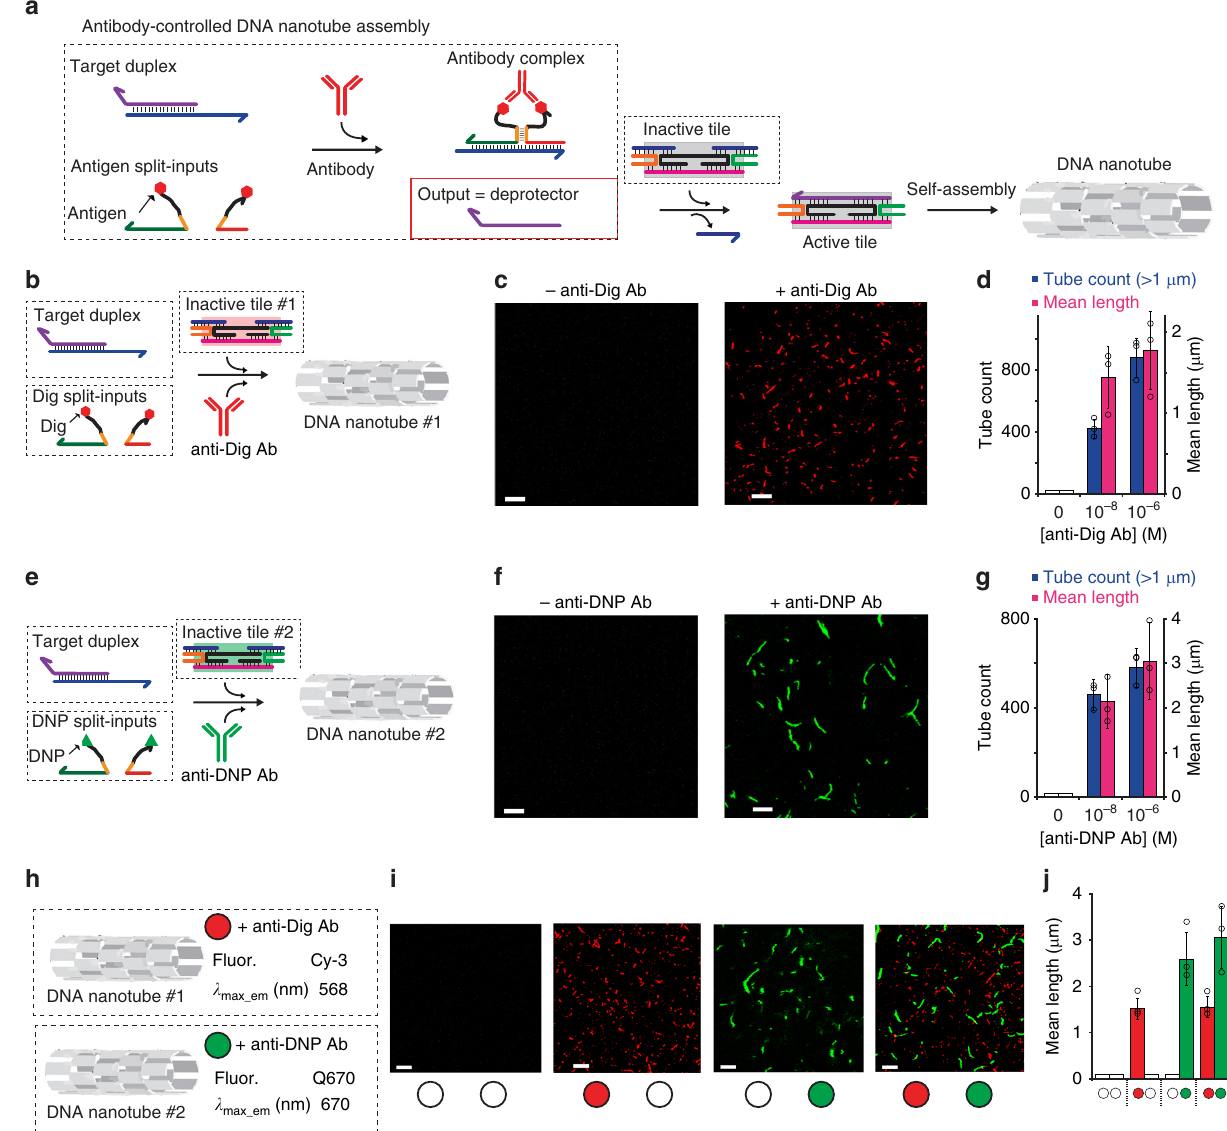
Fig. 3 Antibody-controlled DNA nanostructure assembly. a Antibody-controlled DNA circuit re-engineered to trigger the assembly of DNA nanotubes. To do this we have initially employed inactive DNA double-crossover tiles 18,19,29,44 formed by six unique DNA strands that can be activated by the antibody- controlled strand displacement output (deprotector). Activated tiles can then self-assemble into nanotubes via interactions of their sticky ends. Because one of the tile-forming strands is labeled with a fl uorophore (Cy3), the formed nanotubes can be observed by fl uorescence microscopy. b DNA circuit controlled by anti-Dig antibody leading to the formation of DNA nanotube#1. c Fluorescence microscopy images of nanotubes in the absence (left) and presence (right) of anti-Dig antibody (300 nM). d Histograms of nanotube length (mean length) and number (tube count, for nanotubes longer than 1 µ m) measured from fl uorescence microscopy images in the presence of different anti-Dig antibody concentrations. e – g DNA circuit controlled by anti-DNP antibody leading to the formation of DNA nanotube#2 labeled with a different fl uorophore shows similar anti-DNP antibody concentration-dependent behavior. h , i Orthogonal control of the two nanotubes self-assembly in the same solution. Filled circles identify the added antibody (red = anti-Dig; green = anti-DNP). j Histograms of nanotube length (mean length) measured from fl uorescence microscopy images. The experiments shown in this fi gure were performed in 1 × TAE, 12.5 mM MgCl 2 at pH 8.0, 25 °C. Nanotubes self-assembly was carried out in the presence of the DNA circuit (target duplex, 220 nM and equimolar concentration of the antigen-conjugated input-strands, 440 nM) and a fi xed concentration of the inactive tile (200 nM). No nanotubes are observed in the absence of the relevant antibody. In the histogram fi gures (panels d , g , j ) the bars corresponding to mean length = 0 where no nanotubes are observed are shown as white bars for a matter of clarity. The experimental values represent averages of three separate measurements and the error bars re fl ect the standard deviations. Scale bars for all microscope images, 5 µ protrudes on the external surface of the assembled nanotubes. to disassemble. We have thus designed two antibody-controlled The toehold serves as a binding domain to trigger a strand DNA-based circuits able to give as outputs a deprotector and an invasion of the sticky ends from an invader strand causing invader strand in the presence of anti-DNP and anti-Dig dissociation of one of the inter-tile bonds. This eventually antibodies, respectively. Also in this case, to quantify nanotube weakens tile-tile interactions enough to cause the nanostructure length via fl uorescence confocal microscopy, tiles were labeled